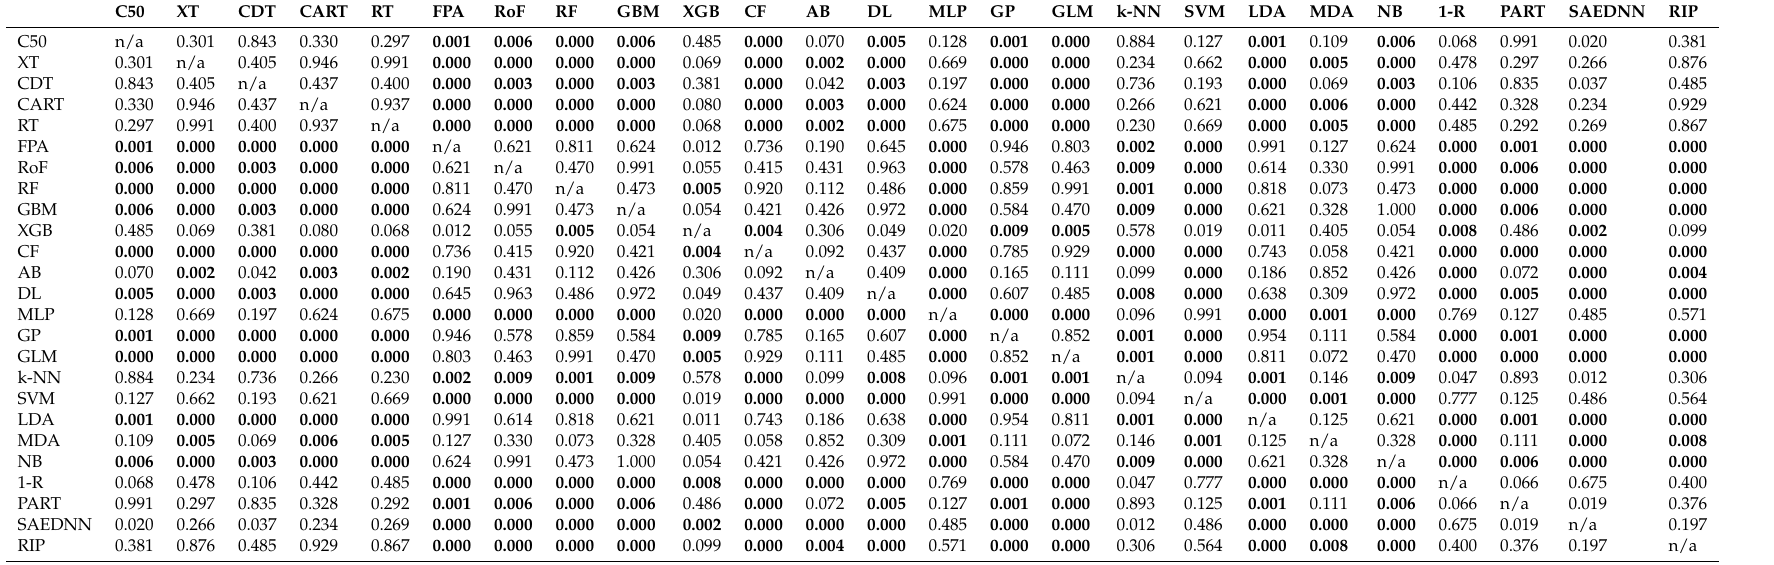
Table 4. Results of post-hoc test using Finner correction w.r.t 5x2cv (bold indicates significance at p -value <